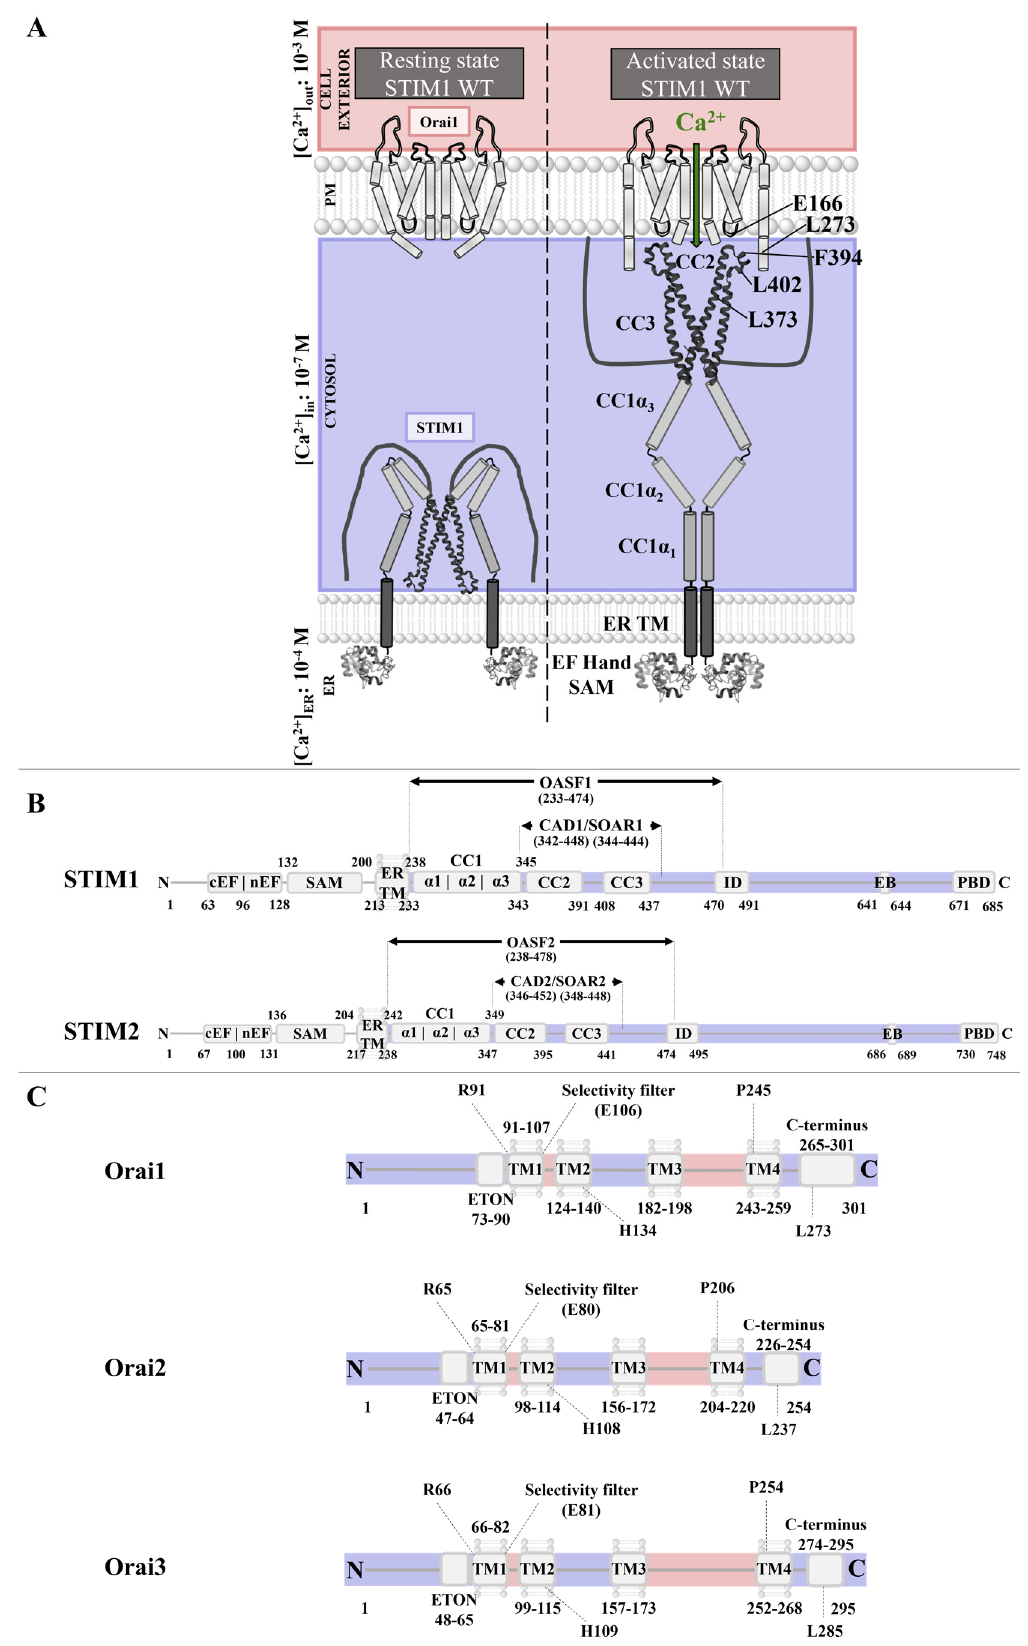
Figure 3. The STIM1 − Orai1 activation mechanism and STIM and Orai isoforms. ( A ) Illustration of the activation mechanism of the CRAC channel, starting with inactive STIM1 and Orai1 in the